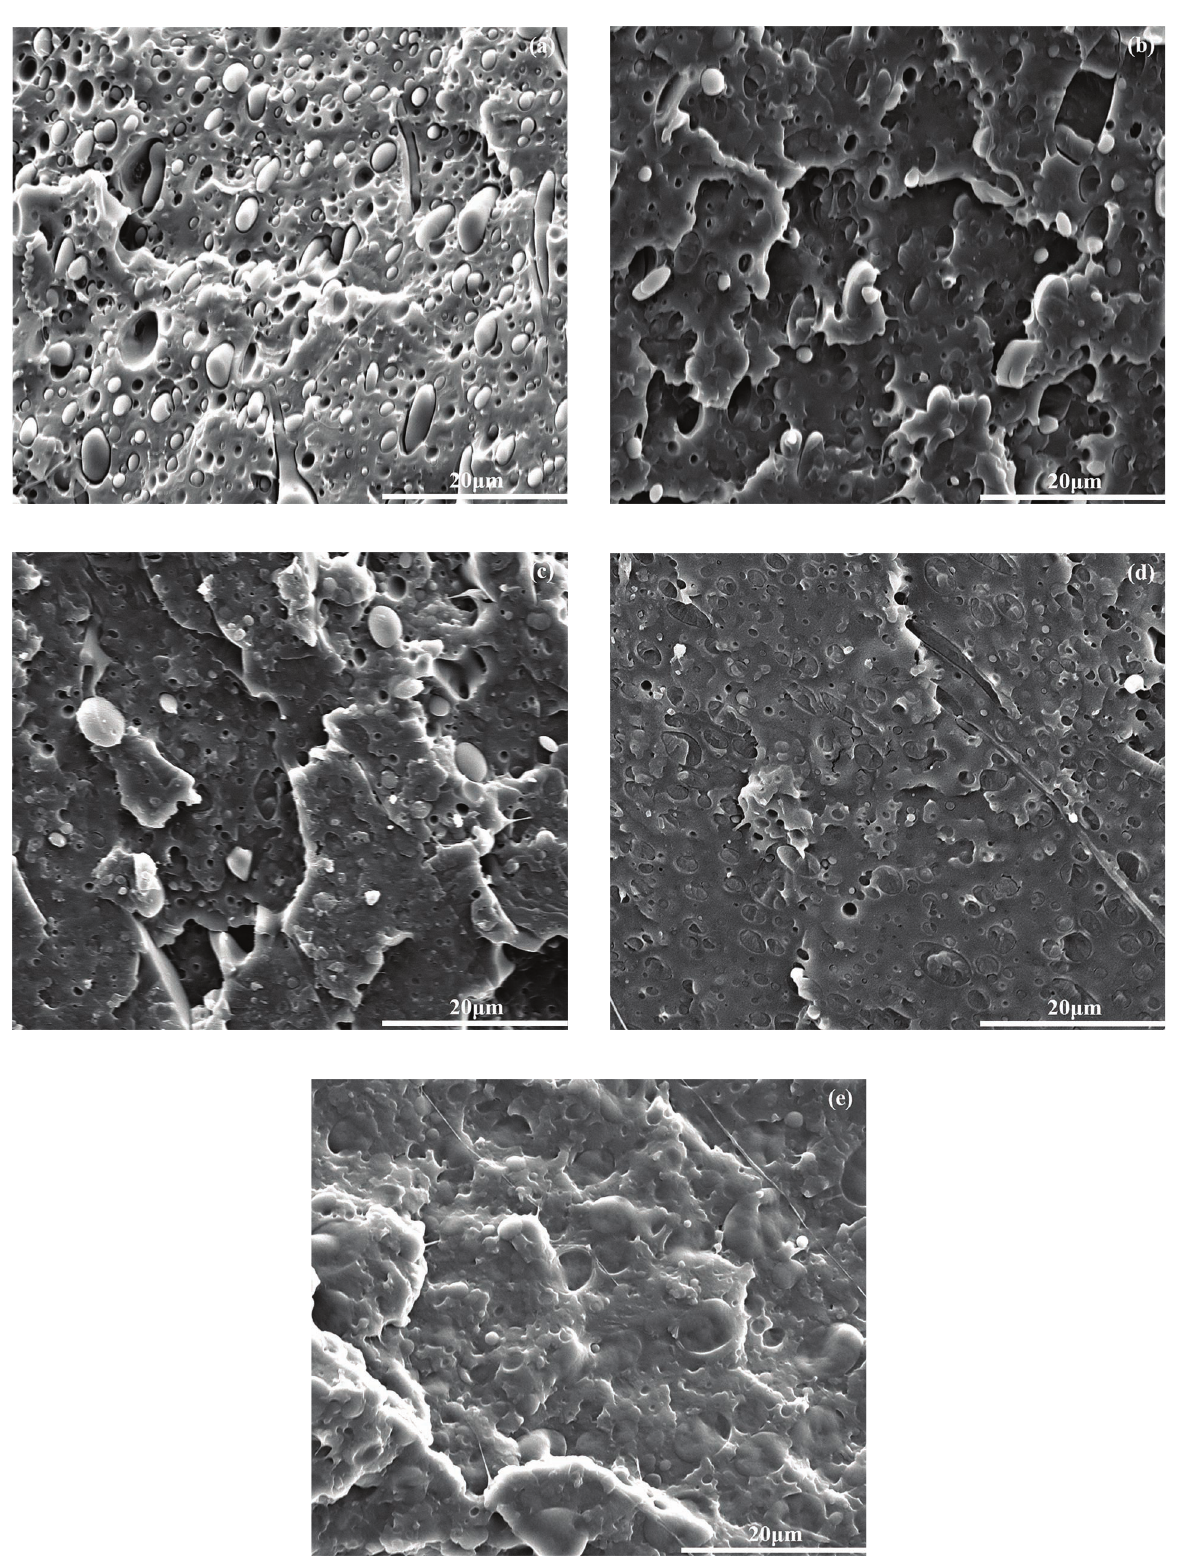
Figure 7: SEM images of the impacted fractures of the PLA/PBAT blends with different content of ETBP: (a) neat, (b) 0.5 phr, (c) 1.0 phr, (d) 3.0 phr and (e) 5.0